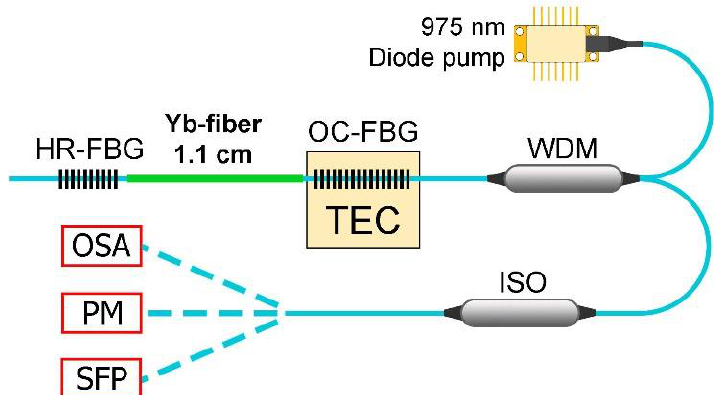
Figure 2. Experimental setup: HR-FBG — high reflection fiber Bragg grating, OC-FBG — output cou- pling fiber Bragg grating, TEC — thermoelectric cooler, WDM — wavelength division multiplexer, ISO — Faraday isolator, OSA — optical spectrum analyzer, PM — power meter, SFP — scanning Fabry – Perot interferometer.